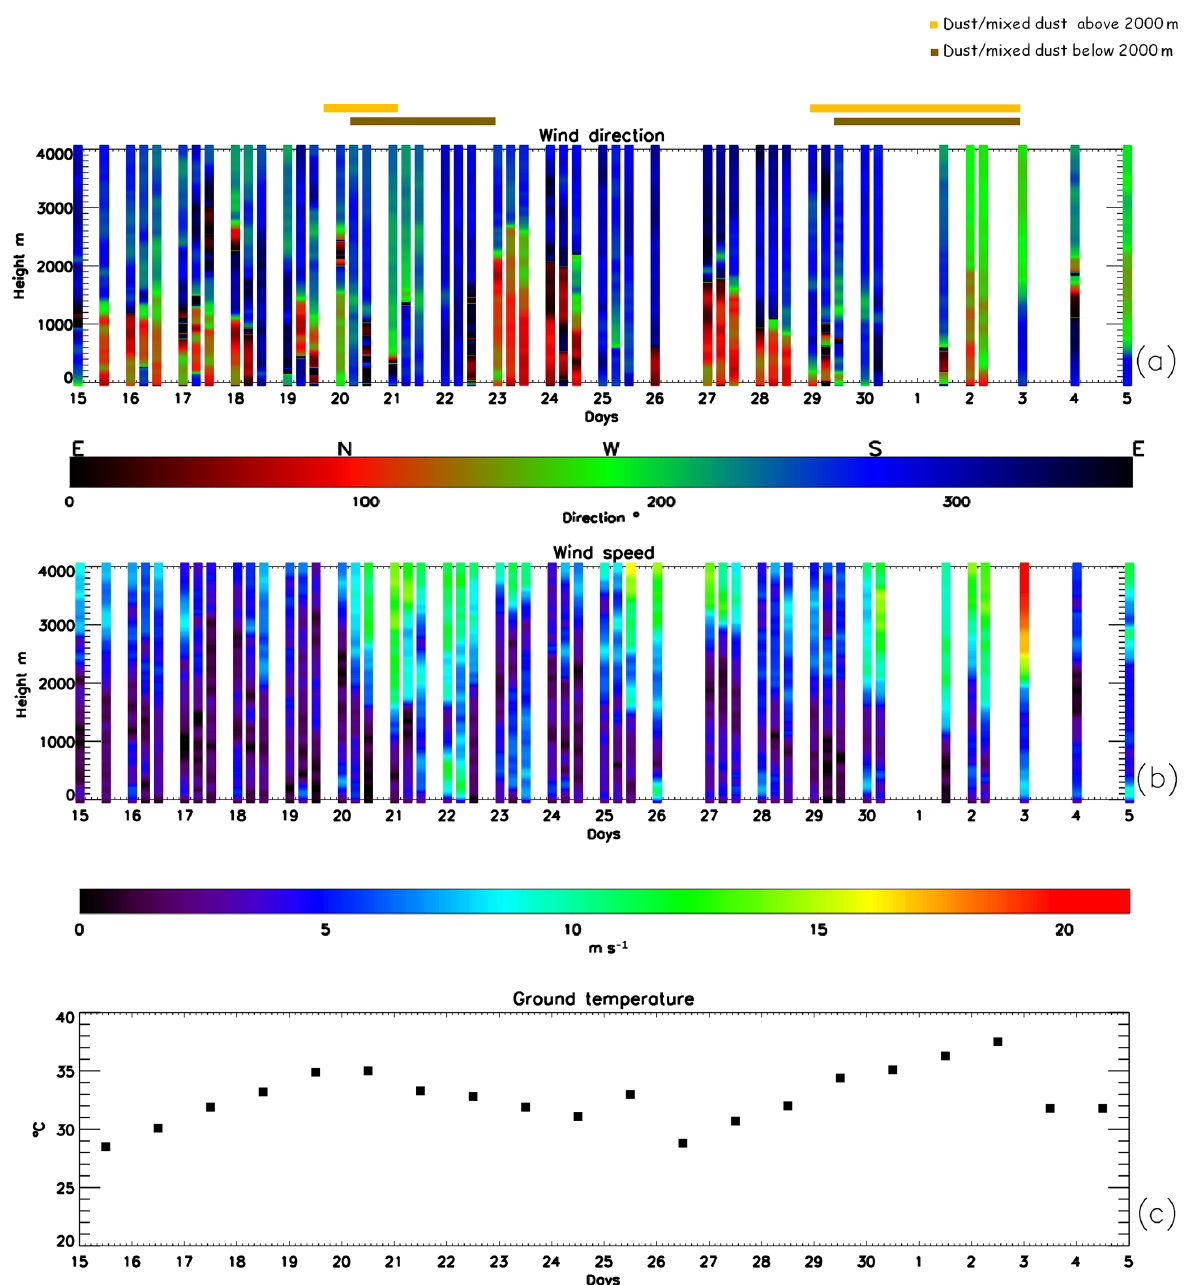
Figure 3. (a) Wind provenance direction. (b) Wind speed. (c) Ground temperature at 12:00UTC. Dust/mixed dust presence, as seen by lidar, is indicated as in Fig.